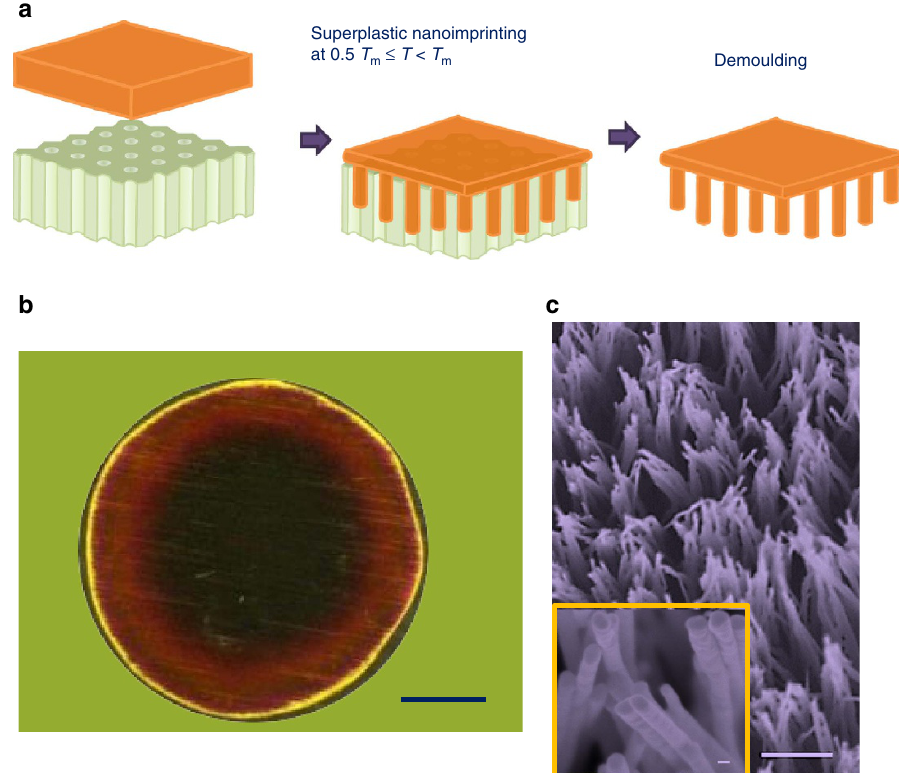
Figure 1 | SPNI of crystalline metals below melting temperatures. ( a ) Schematic of the SPNI process. ( b ) Optical micrograph of an as-thermoplastic- formed Au/Al 2 O 3 template combination, which was prepared by SPNI under an applied force of 5kN and holding for B 60min (Scale bar, 1mm). The uniform rust-red colour of the sample suggests that Au nanowire arrays have been replicated, which is verified by characterizing the sample under SEM after dissolving the Al 2 O 3 template in KOH solution (( c ) scale bar, 5 m m. Inset figure scale bar,